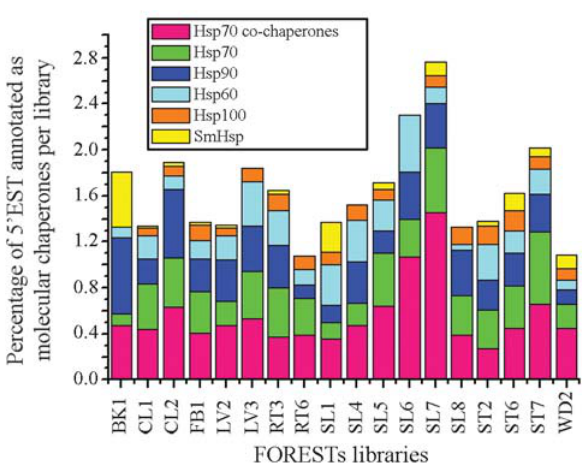
Figure 3 - Expression of the chaperone families in the different tissues of eucalyptus. The percentages represent the number of 5’EST associated to chaperone genes in each library. The colors indicate the contribution of each chaperone family. The FORESTs libraries are: BK1 (bark, duramen, pith, and alburnum); CL1 ( E. grandis callus formed in the dark), CL2 ( E. grandis callus formed in the light); FB1 (flower buds, flowers, and fruits); LV2 (leaves of efficient and inefficient trees in Phosphorus and Boron utilization); LV3 (leaves colonized by the Thyrinteina grub for seven days); RT3 (roots from seedlings); RT6 (roots from trees resistant and susceptible to frost); SL1 ( E.grandis seedlings cultivated in the dark and exposed to light for three hours before the RNA extraction); SL4 ( E. globulus seedlings cultivated in the dark); SL5 ( E. saligna seedlings cultivated in the dark); SL6 ( E. urophylla seedlings cultivated in the dark); SL7 ( E. grandis seedlings cultivated in the dark); SL8 ( E. camaldulensis seedlings cultivated in the dark); ST2 (stem from six month seedlings sus- ceptible to hydric deficit); ST6 (seedlings stem susceptible to hydric defi- cit); and WD2 ( E. grandis